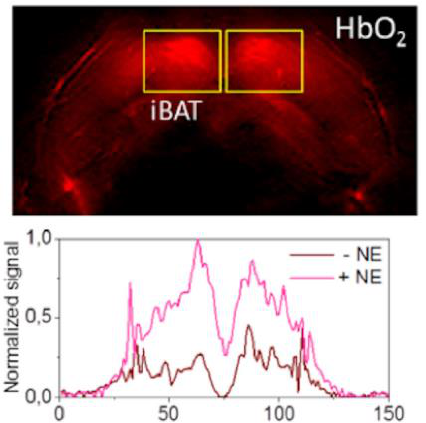
Figure 11. MSOT HbO 2 map after norepinephrine treatment. MSOT image unmixed for HbO 2 signal of murine interscapular BAT after treatment with norepinephrine (NE; top panel). BAT pads are shown in rectangles. The bottom panel shows the horizontal intensity profile with and without NE treatment. Image reproduced with permission from reference 95.